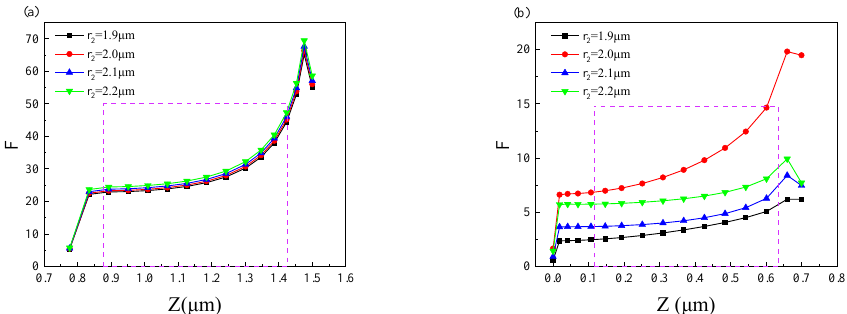
Figure 7. The effect of changing the r 2 of the middle metal disk on the enhancement factor: ( a ) the effect of different r 2 on the enhancement factor of the top quantum well layer (QW1) and ( b ) the effect of different r 2 on the enhancement factor of the bottom quantum well layer (QW2).